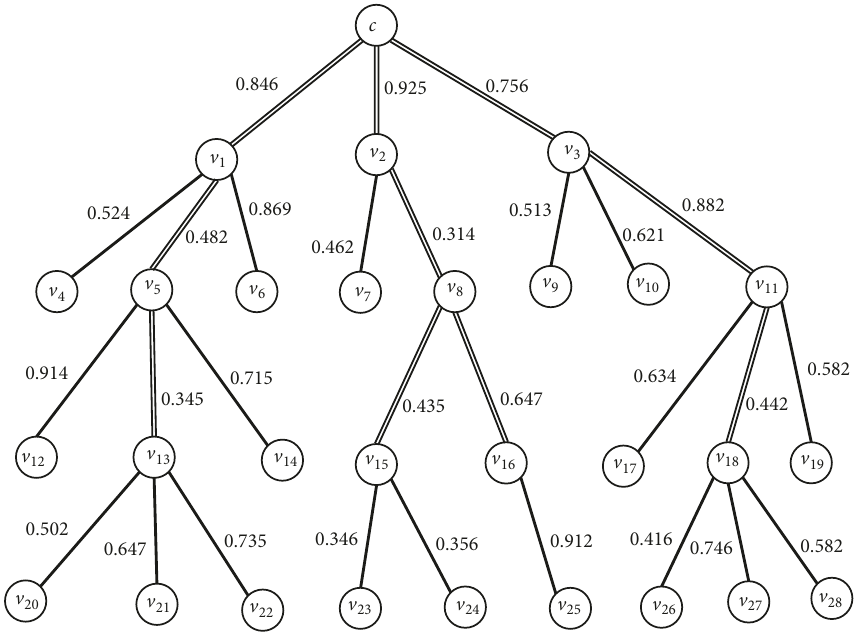
Figure 4: The induced ⟨Λ 𝑐 ⟩ optimal reliable (4,3)− tree core of 𝑇 𝑐 shown in double lines.